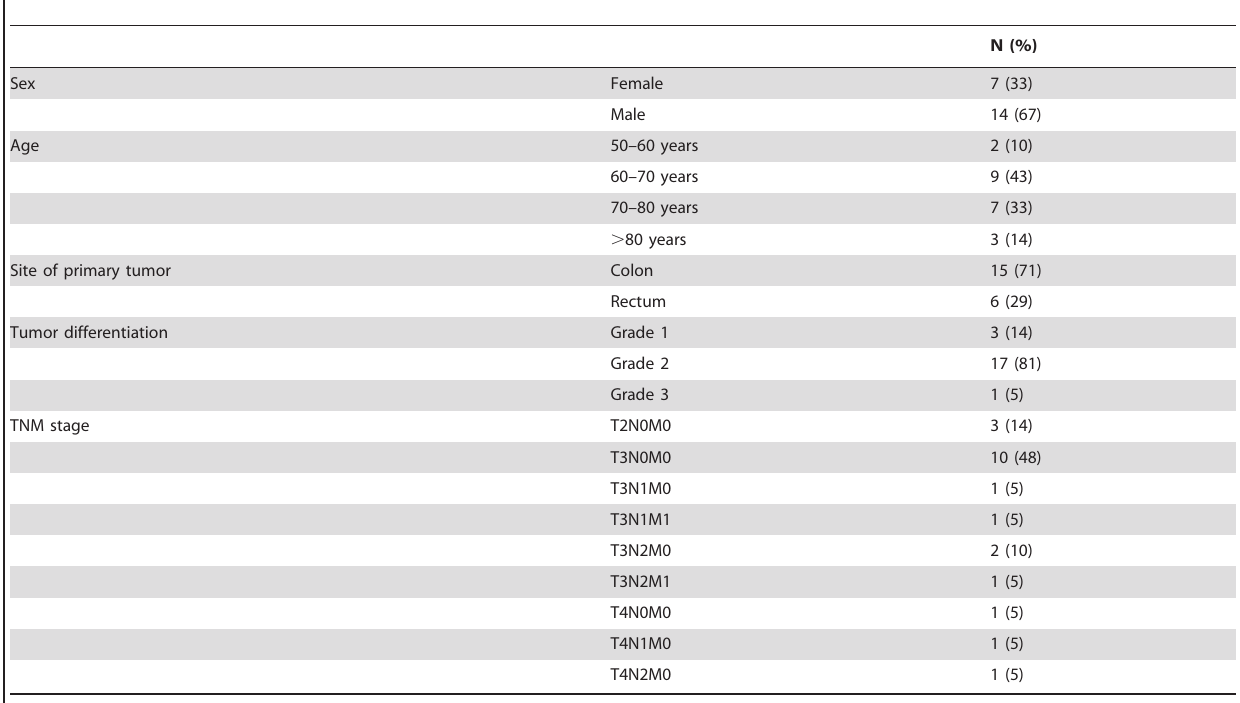
Table 1. Characteristics of patients and tumors.